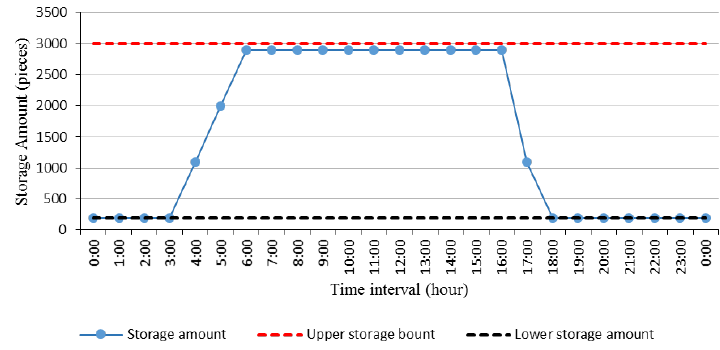
Figure 12. Storage amount of spare parts during each time interval.